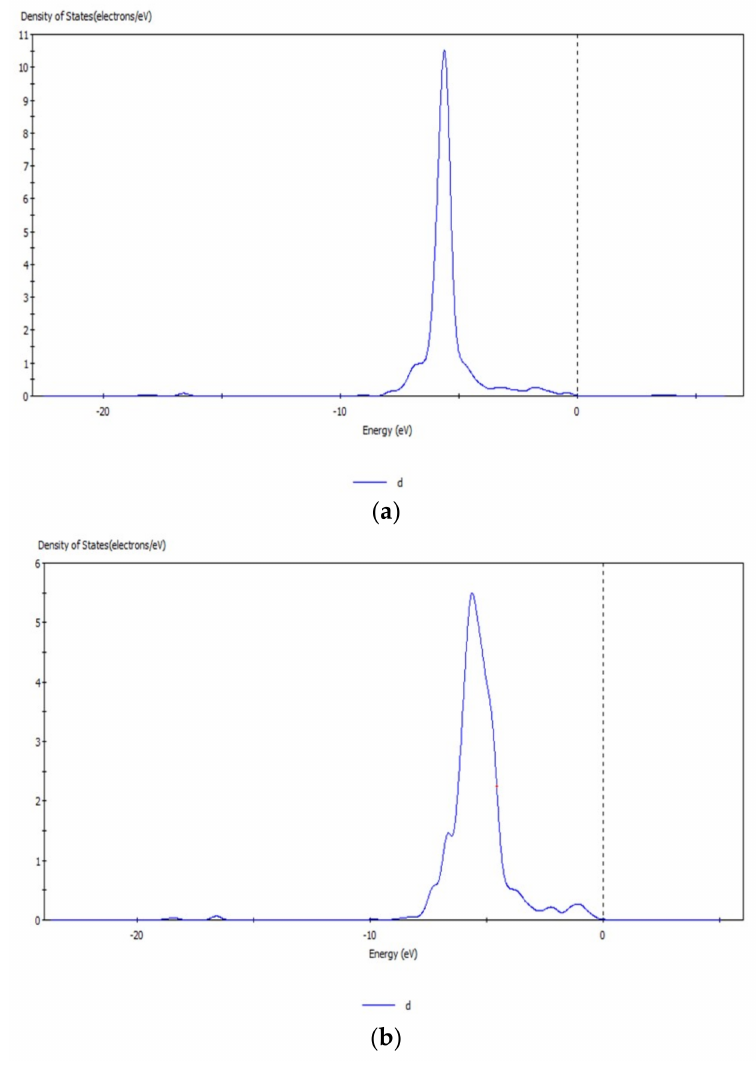
Figure 10. d orbital before ( a ) and after ( b ) transformation of CO 32 − with